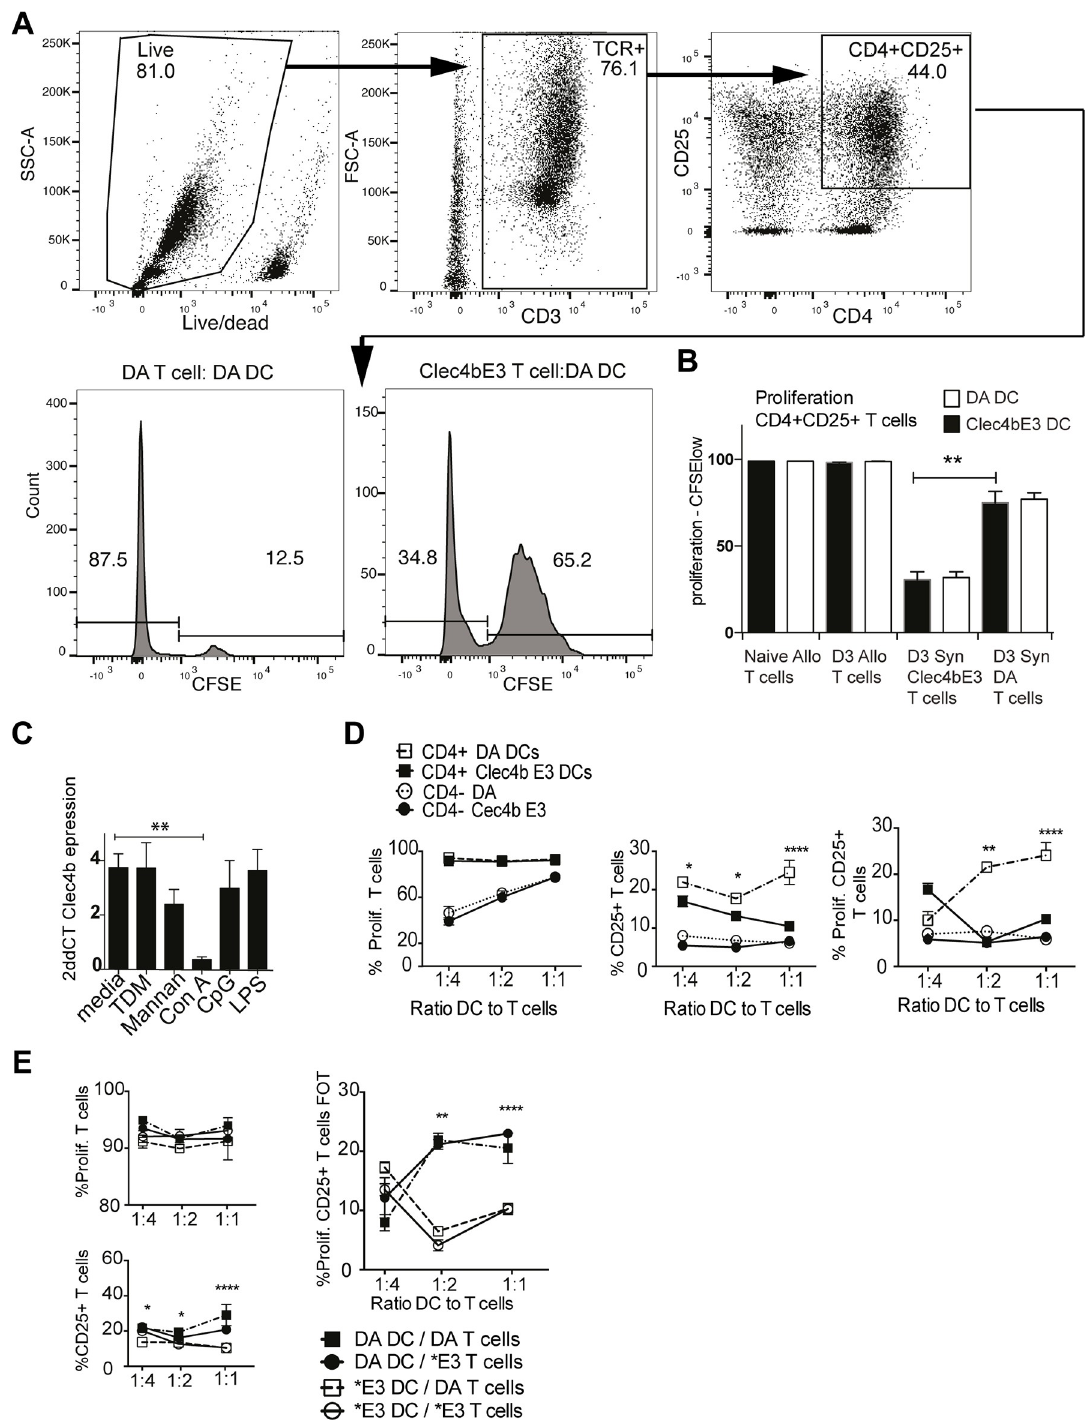
Fig 6. Clec4b regulates CD4 + myeloid cell mediated suppression of na ï ve T cells in mixed lymphocyte reactions. a) Illustration of the gating for activated T cells, by first gating for live cells, then T cells, and CD4 + CD25 + cells followed by proliferation as carboxyfluorescein succinimidyl ester (CFSE) low. And an illustration of CFSE histogram for two samples. b) Graph describes proliferation as CFSE low labeled CD4 + CD25 + T cells from a) for Na ï ve or OIA Day 3 activated allogenic T cells and OIA Day 3 activated syngenic DA or Clec4b E3 T cells. The T cells have been co-cultured with OIA day 3 in vivo activated DCs from both genotypes, or cultured with na ï ve DCs from both genotypes (only for na ï ve allogenic T cells). c) In vitro stimulated Clec4b gene expression in CD4